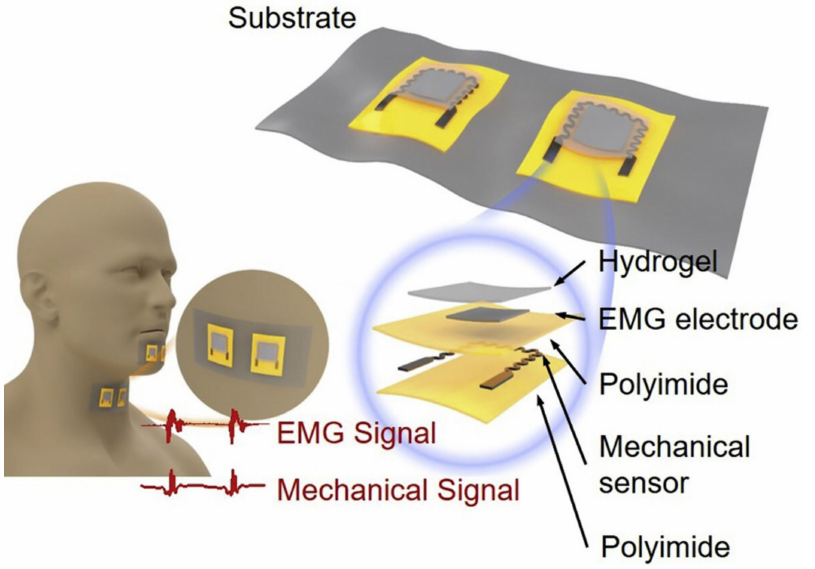
Figure 14. The bioinspired dual-channel speech recognition system. Reproduced with permission from [25]. Copyright 2022 Cell